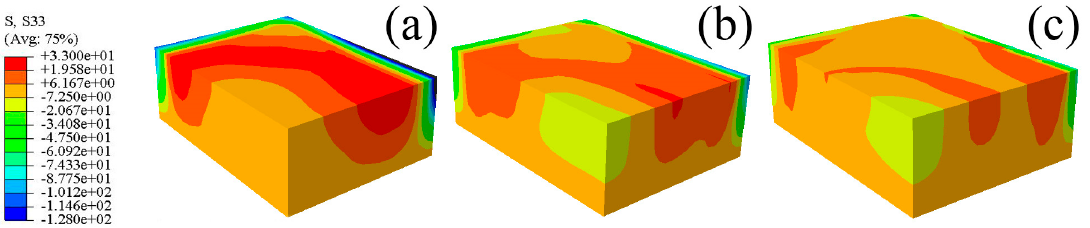
Figure 13. Predicted residual stresses contours of the 1/8 model for the S22 component; ( a ) 20 °C; ( b ) 40 °C; ( c ) 60 °C.